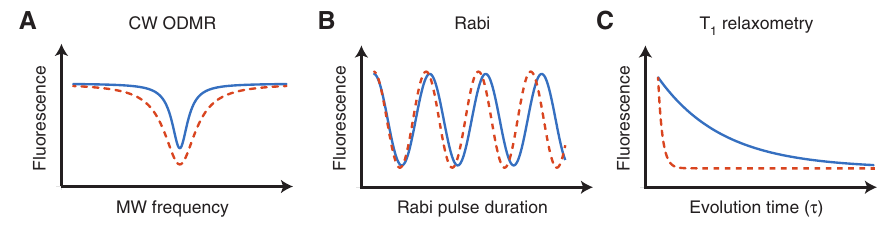
Figure 8: GHz magnetometry protocols. (A) CW ODMR broadening: increased MW power will increase ODMR fluorescence contrast and linewidth (red). (B) Rabi oscillation: increased amplitude of the MW field will increase the Rabi frequency (red). (C) T high-frequency magnetic noise near the NV resonance